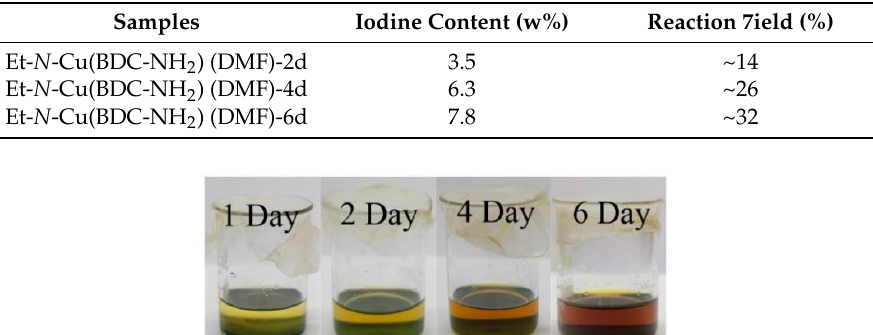
Table 8. The reaction yield from Cu(BDC-NH 2 )(DMF) to Et- N -Cu(BDC-NH 2 )(DMF).